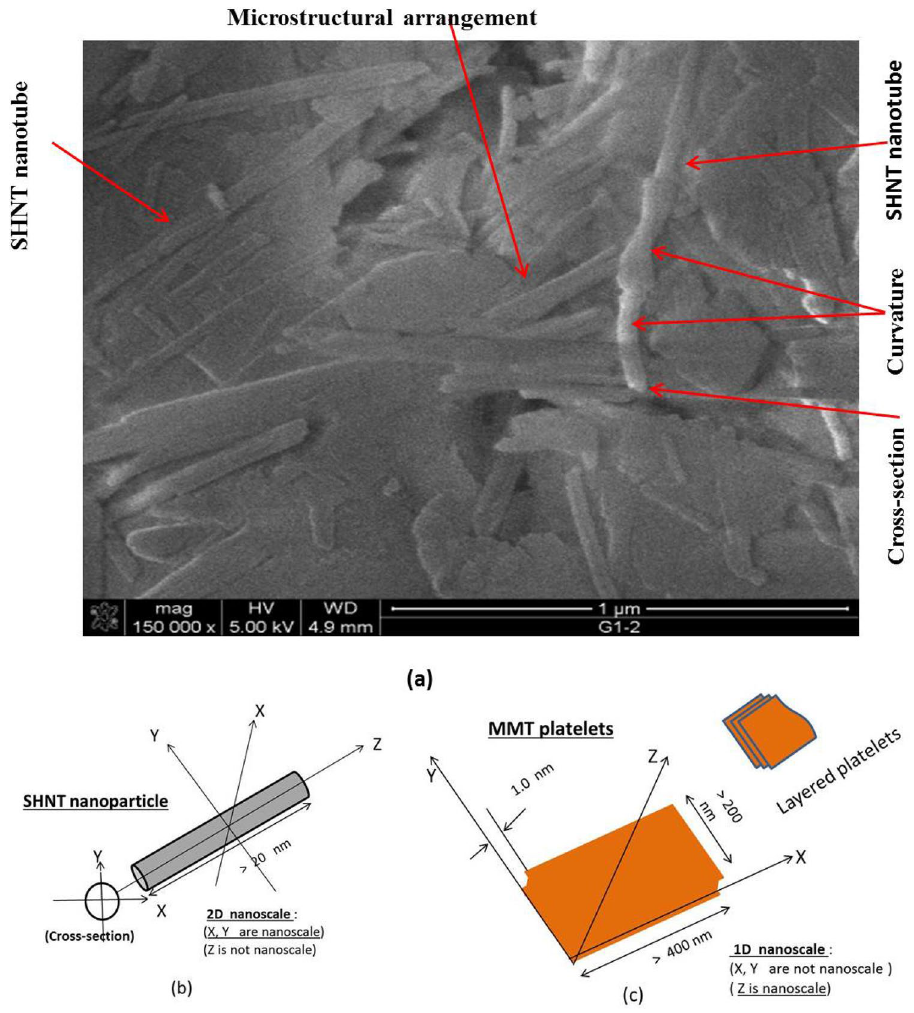
Figure 1. SEM image showing the SHNT microstructure, dimensions, geometry, cross-section and